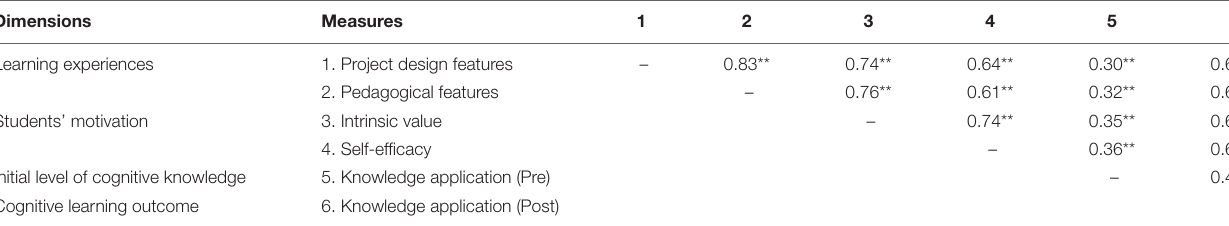
TABLE 2 | Correlation between motivation, learning experiences, and learning outcomes.